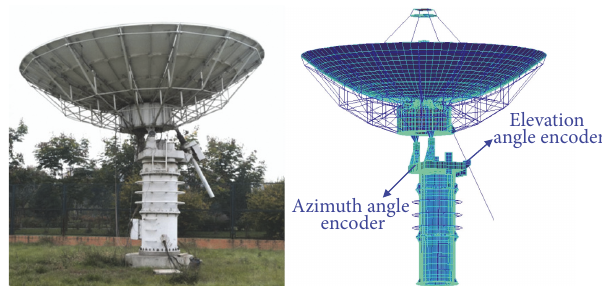
Figure 5: The real and finite element model of 7.3m antenna.